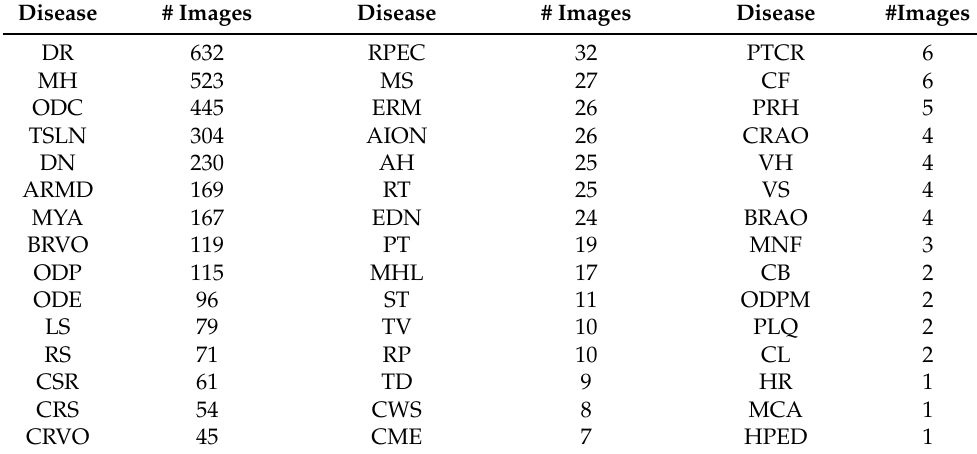
Table 6. Annotation frequency for each class in the RFMiD